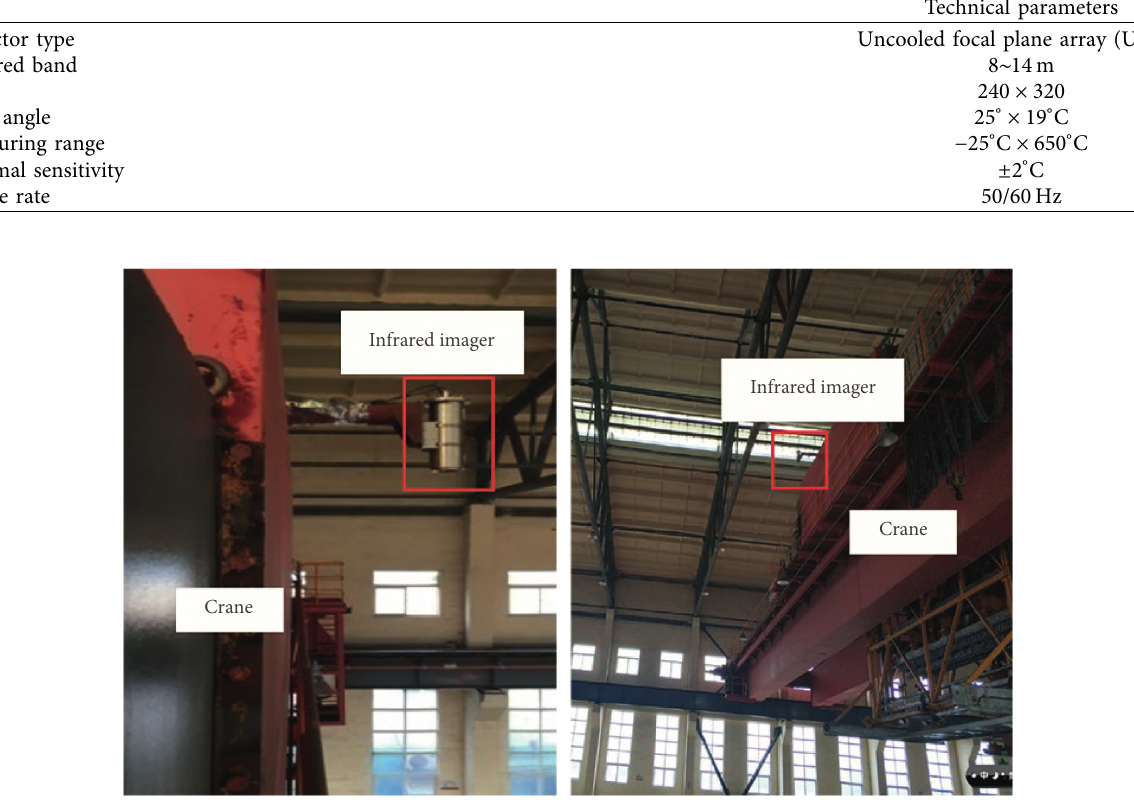
Figure 15: Infrared camera mounted on the